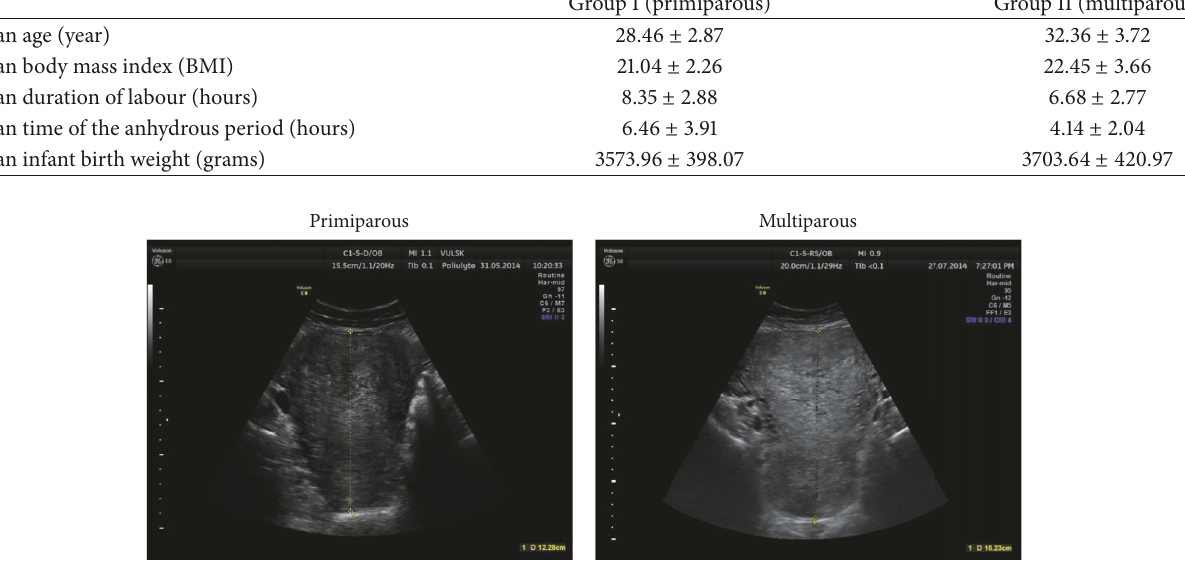
Figure 4: Coronal view of uterus was measured on the 1st day (within two hours after labour).